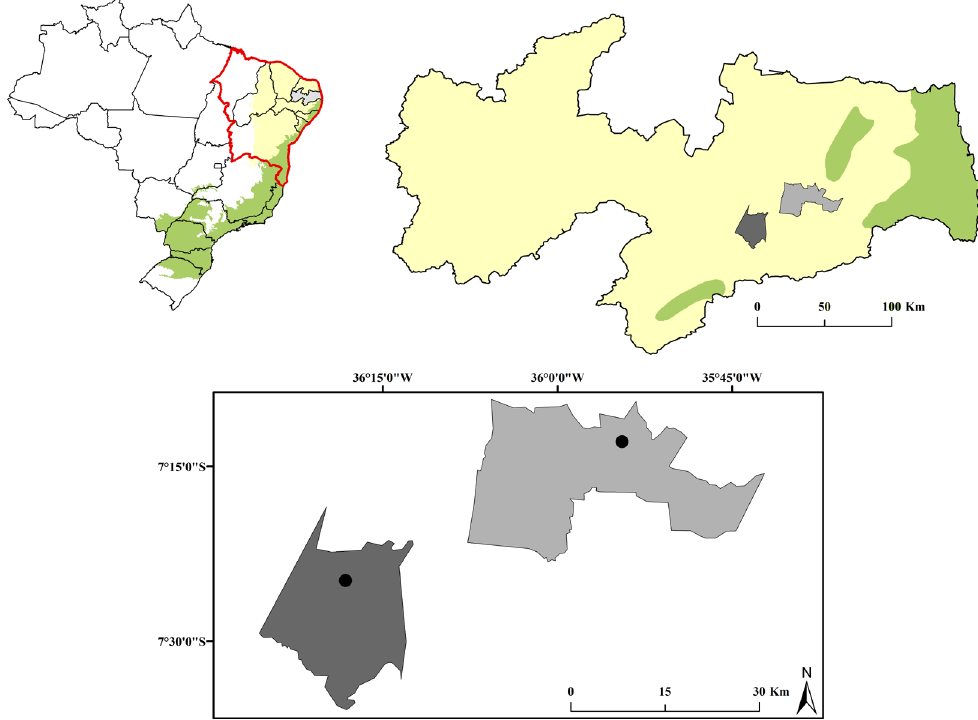
Figure 1. Sampling areas ( ● ). Legend: red line = Northeastern Brazil limit; yellow area = Caatinga formation; green area = Atlantic